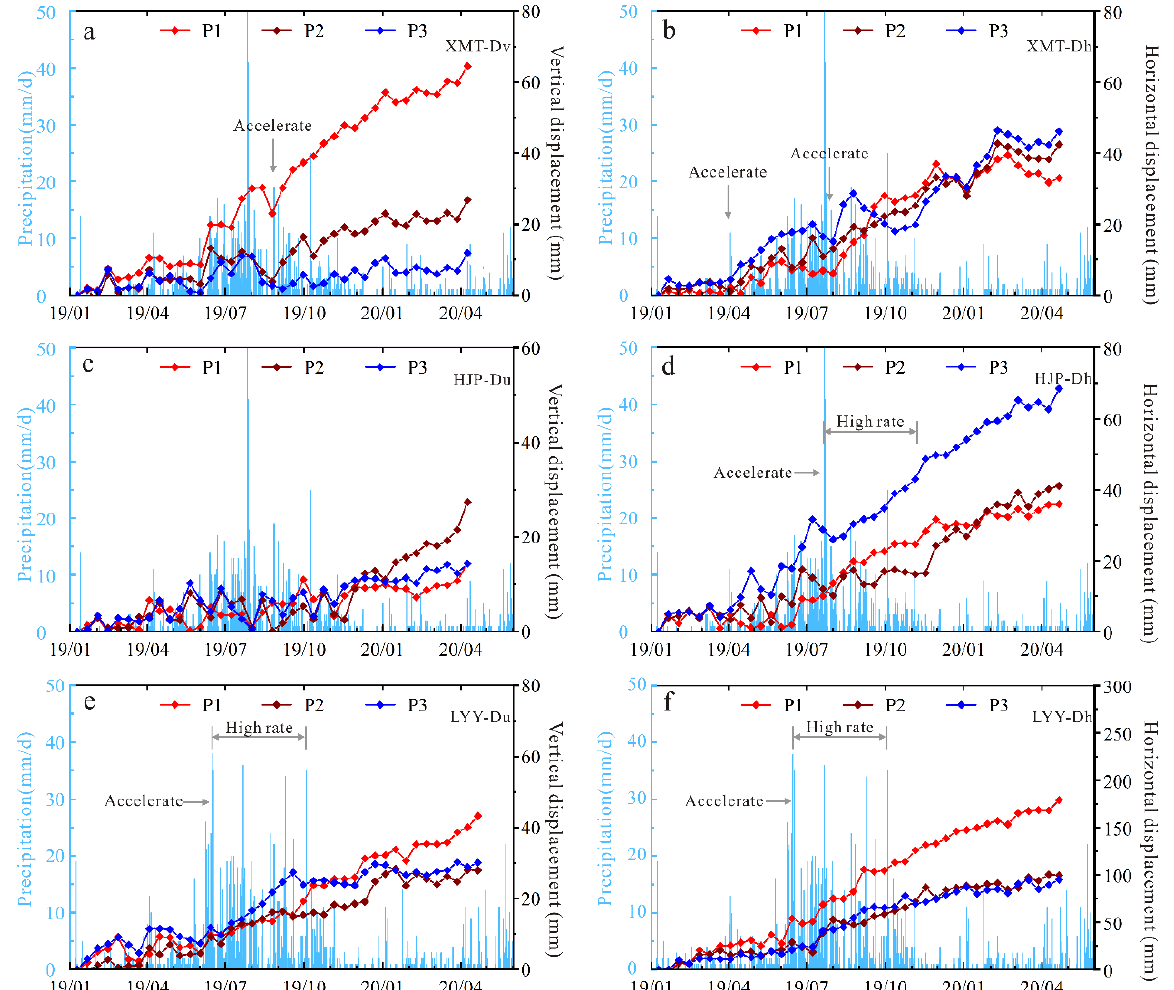
Figure 14. Time-series displacement of typical landslides’ monitoring points with daily rainfall. ( a ) Vertical displacement of XMT landslide; ( b ) horizontal displacement of XMT landslide; ( c ) vertical displacement of HJP landslide; ( d ) horizontal displacement of HJP landslide; ( e ) vertical deformation of LYY landslide; ( f ) horizontal displacement of LYY landslide. (P1, P2, and P3 correspond to the landslide investigation points in Section 3.2).